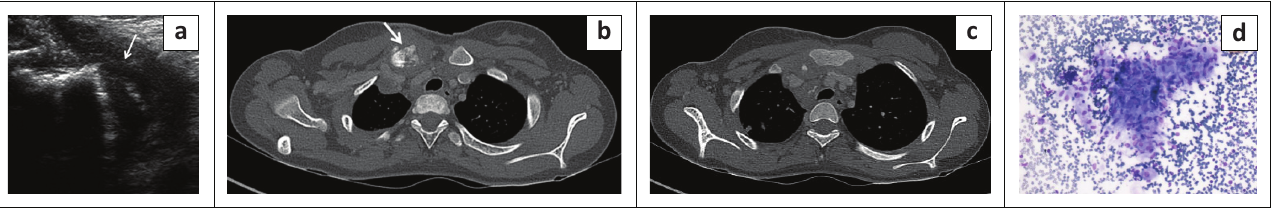
FIGURE 1: A 13-year-old female with swelling over the right sternoclavicular joint. Ultrasonography (a) of the affected area shows a hypo-echoic collection (white arrow) with internal echoes, reaching up to the skin surface. Post-contrast axial computed tomography bone window images (b, c) revealed the involvement of the medial end of the clavicle (white arrow) and adjacent hypodense collection with sparing of the sternal aspect. Fine needle aspirate (d) shows a well-formed caseating granuloma composed of the epithelioid cells with characteristic slipper-shaped nuclei and indistinct cell boundaries (May-Grünwald-Giemsa x